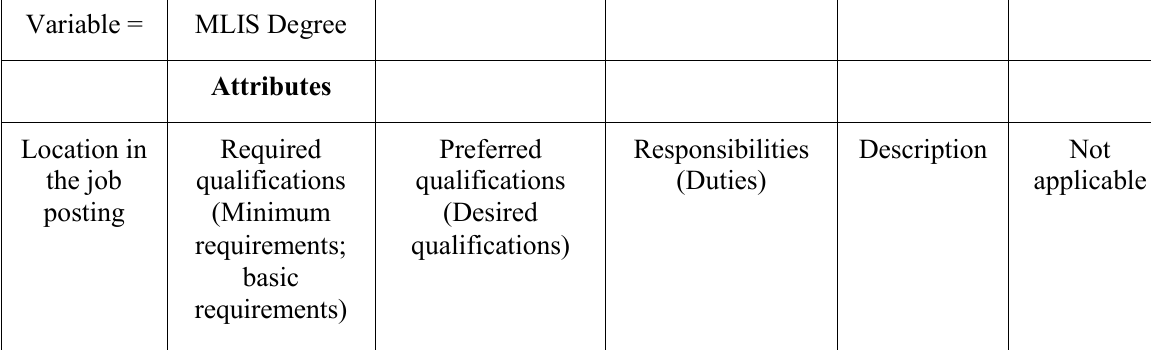
Table 1 : Attributes for the variable ‘ MLIS Degree ’. Synonyms for each attribute are shown in